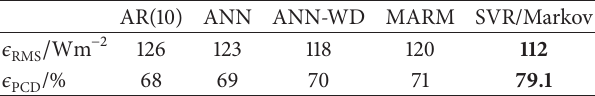
Table 7: Results concerning the sixty-step ahead solar radiation prediction over validation